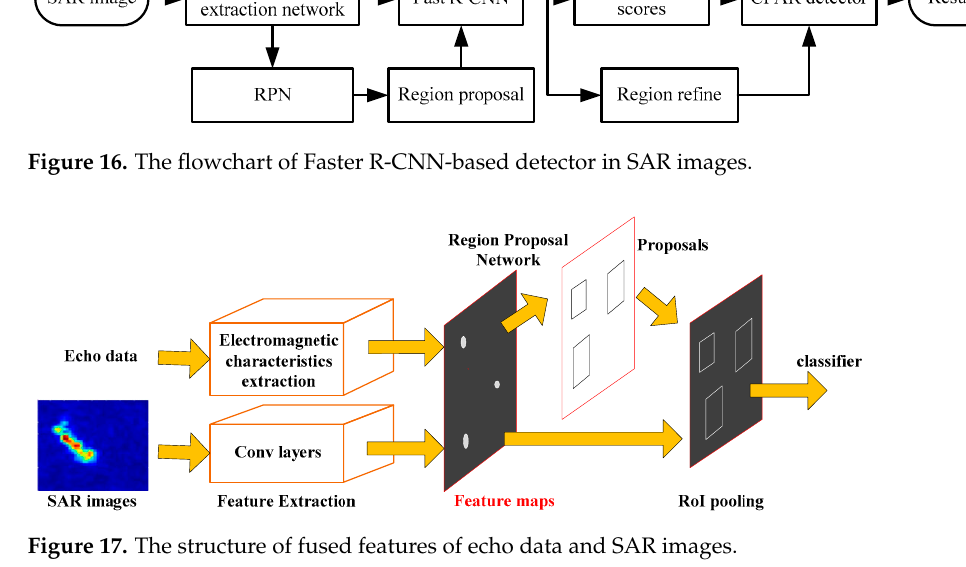
Figure 17. The structure of fused features of echo data and SAR images.